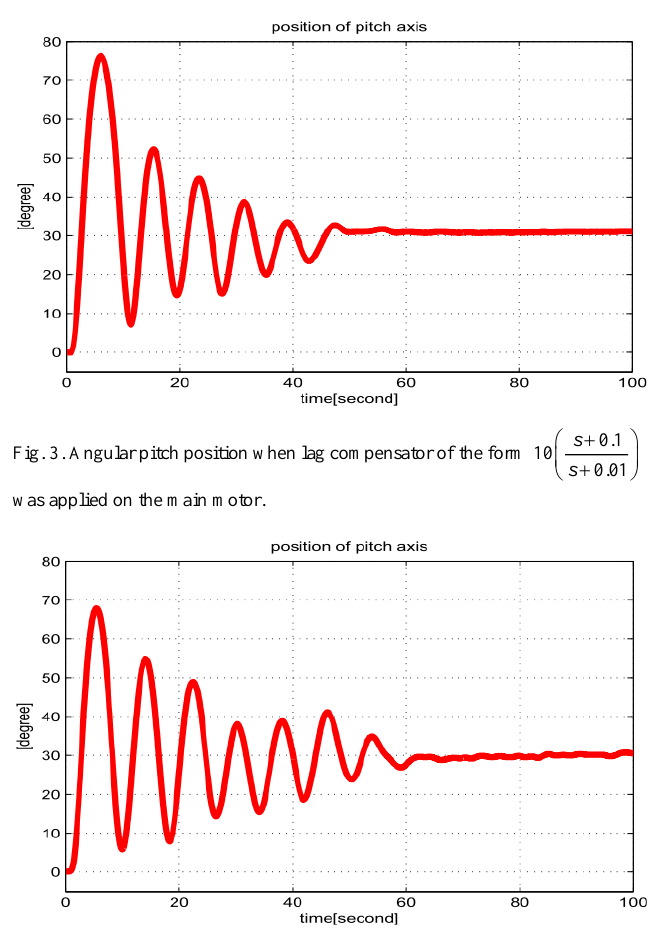
Fig. 4. Angular pitch position when lag-lag compensators of the form 2 0.1 s +  was applied on the main motor. 10   0.01 s + 